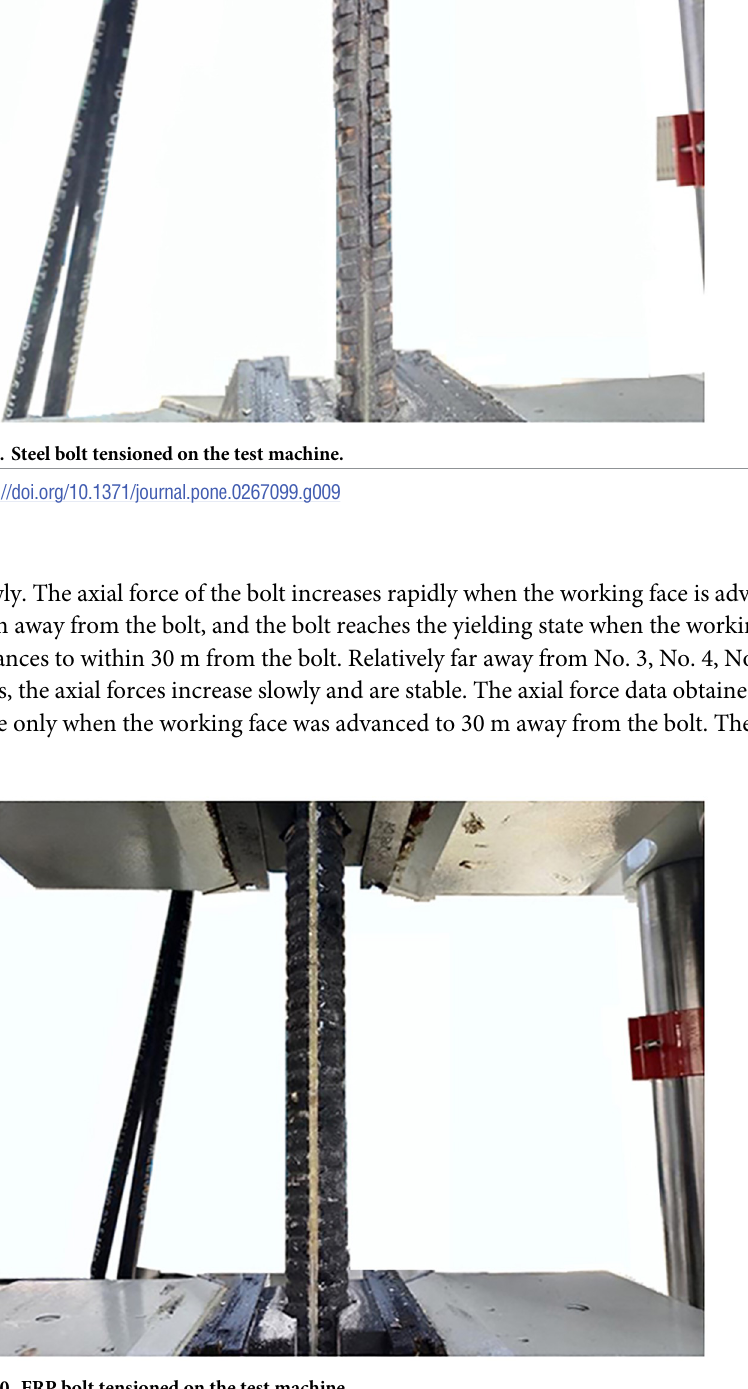
Fig 10. FRP bolt tensioned on the test